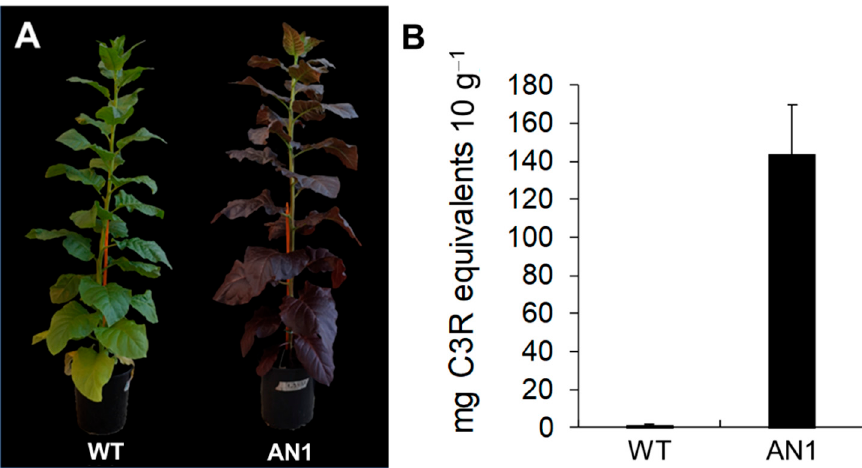
Figure 2. StAN1 overexpression induces anthocyanin accumulation in tobacco plants. ( A ) Phenotype of a representative plant for wild-type (WT) and plants carrying p35S: StAN1 (AN1) at the end of the growth cycle; ( B ) Anthocyanin leaf content expressed as C3R equivalents.